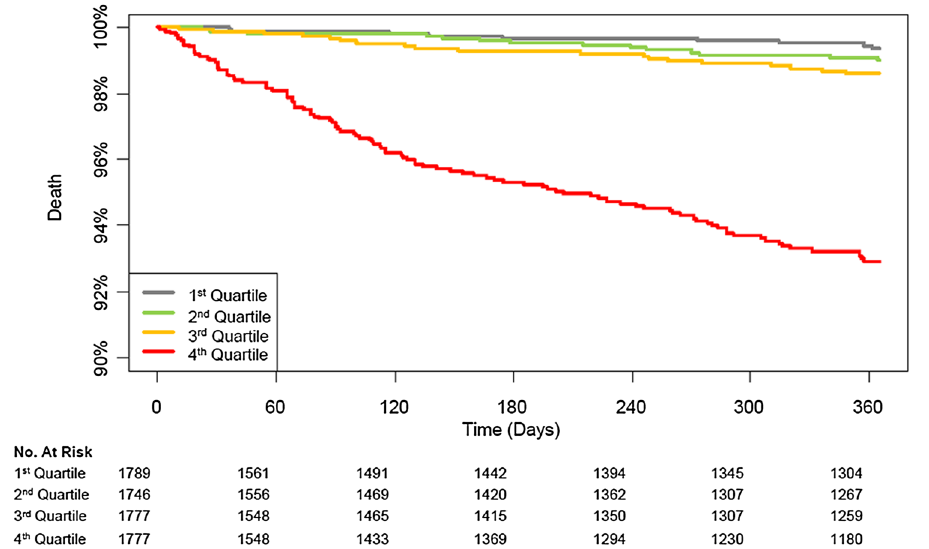
Figure 2. Kaplan Meier curves of the groups divided by quartile for mortality during